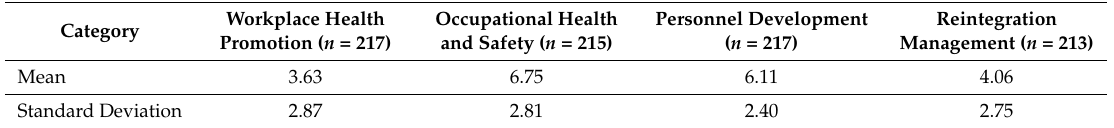
Table 4. Average standardized implementation grade (implementation scale mean) in four categories of health-related measures (total sample, N =